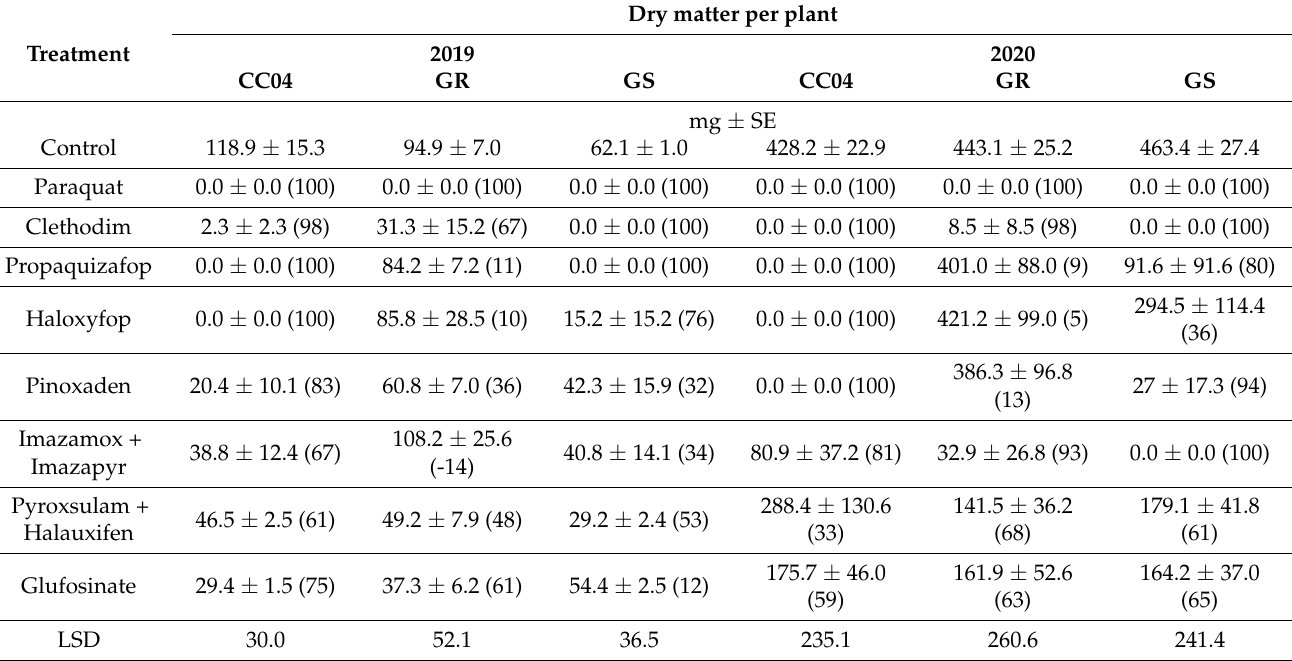
Table 5. Dry weight of three Lolium rigidum populations after treatment with different herbicides in two experimental runs (2019 and 2020). Data are presented as the mean dry matter per plant ± the standard error (SE) of the mean. The data in parentheses represent the percentage of dry weight reduction compared to the control